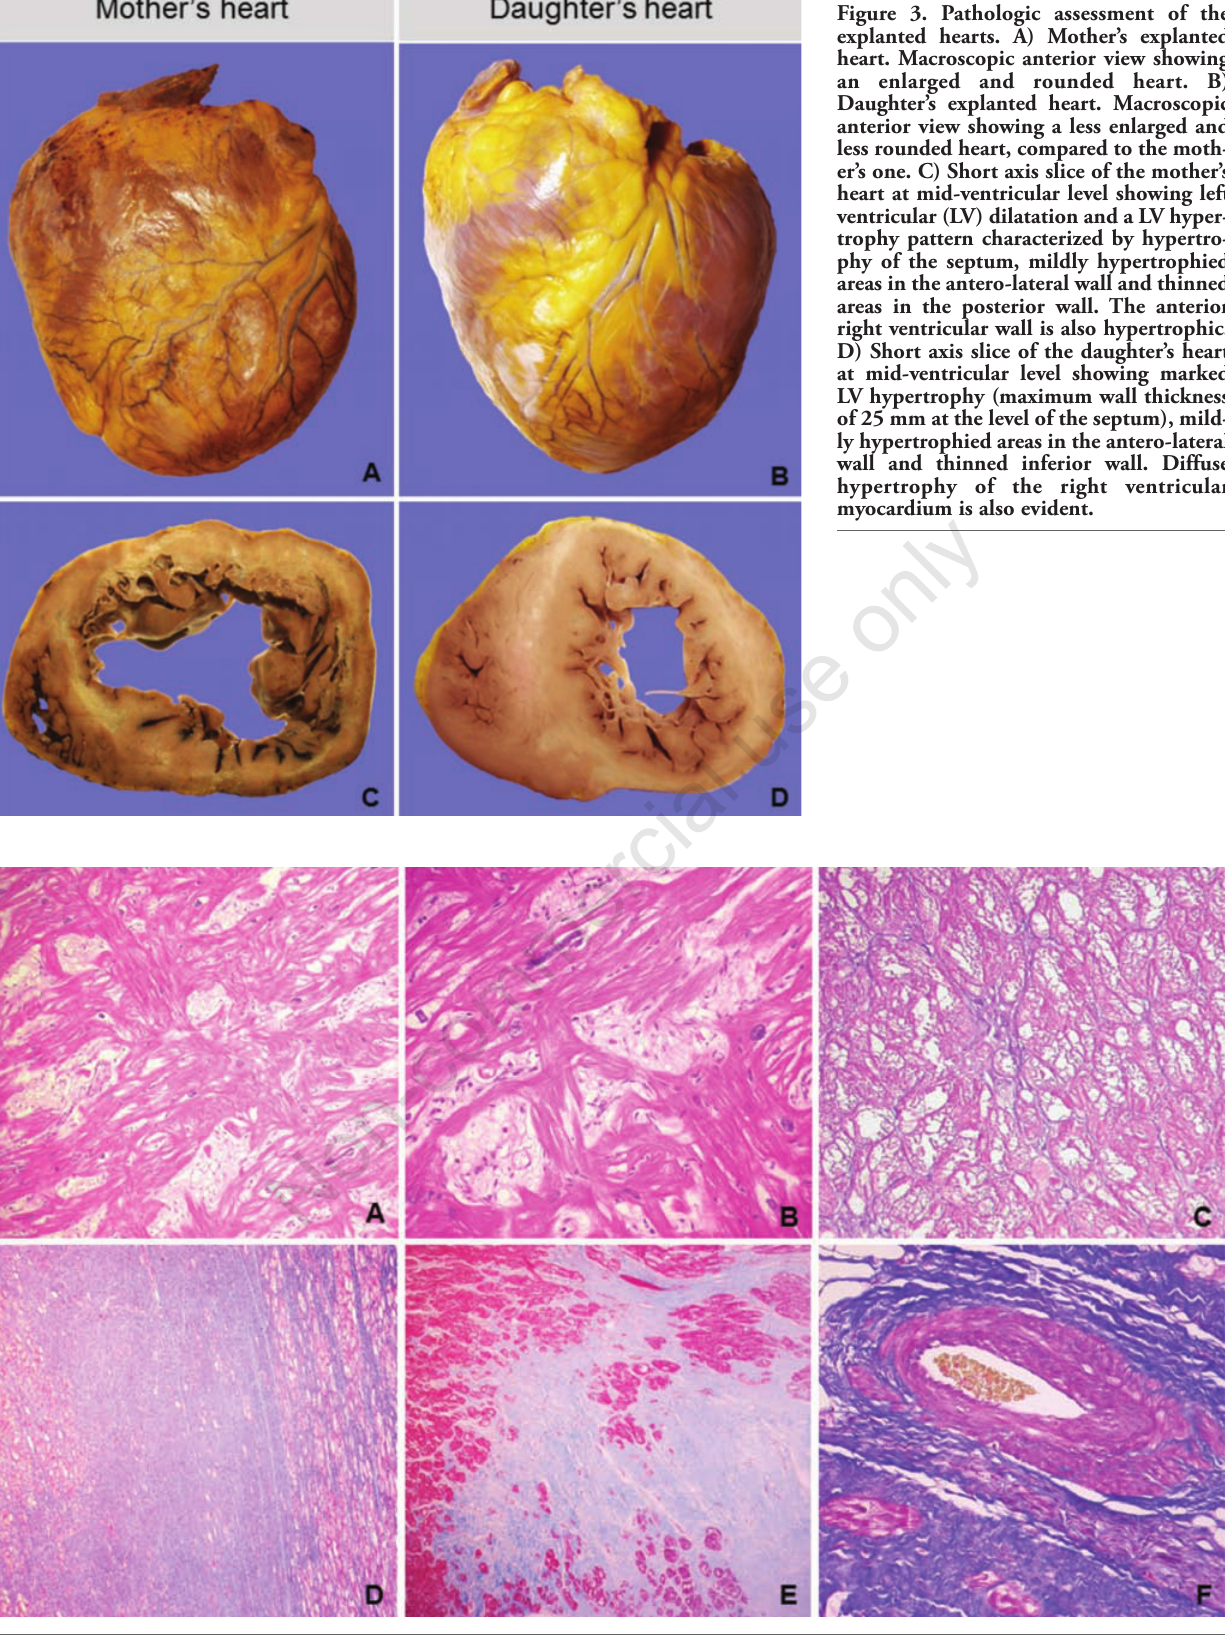
Figure 4. Hystologic assessment of both hearts showing myocyte hypertrophy and multiple myocardial disarray (A-B), extensive and marked sarcoplasmic vacuolization of the myocytes (C), extensive replacement fibrosis (D-E) and mild to moderate vasculopathy of small mural vessels